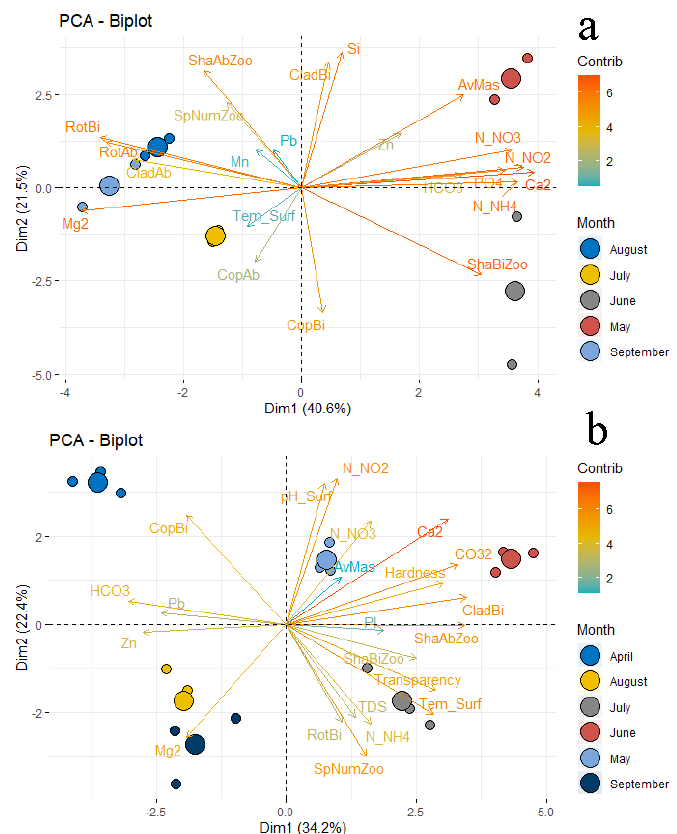
Figure 10. Principal component analysis (PCA) biplot of relationships between environmental var- iables and zooplankton communities in wastewater RSC 7 ( a ) and RSC 8 ( b ), 2021. The